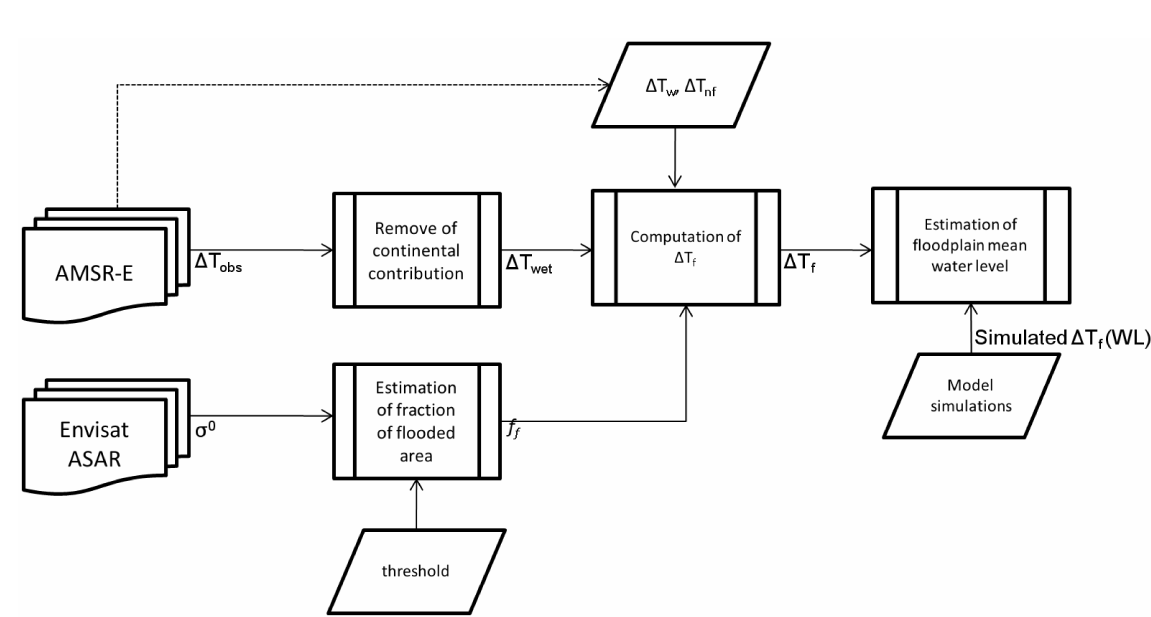
Fig. 5. Flow diagram of the